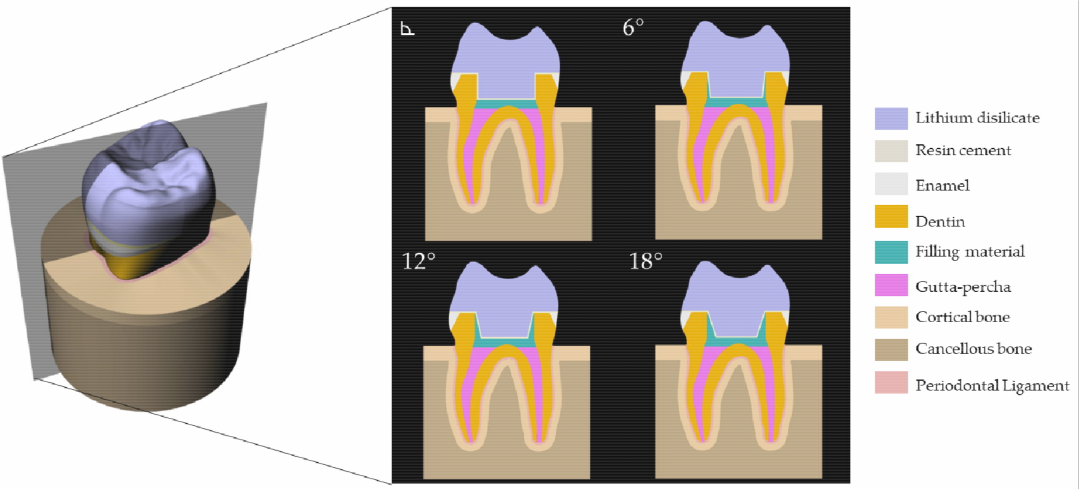
Figure 1. Three-dimensional model created in the modeling software with different provisional endocrown